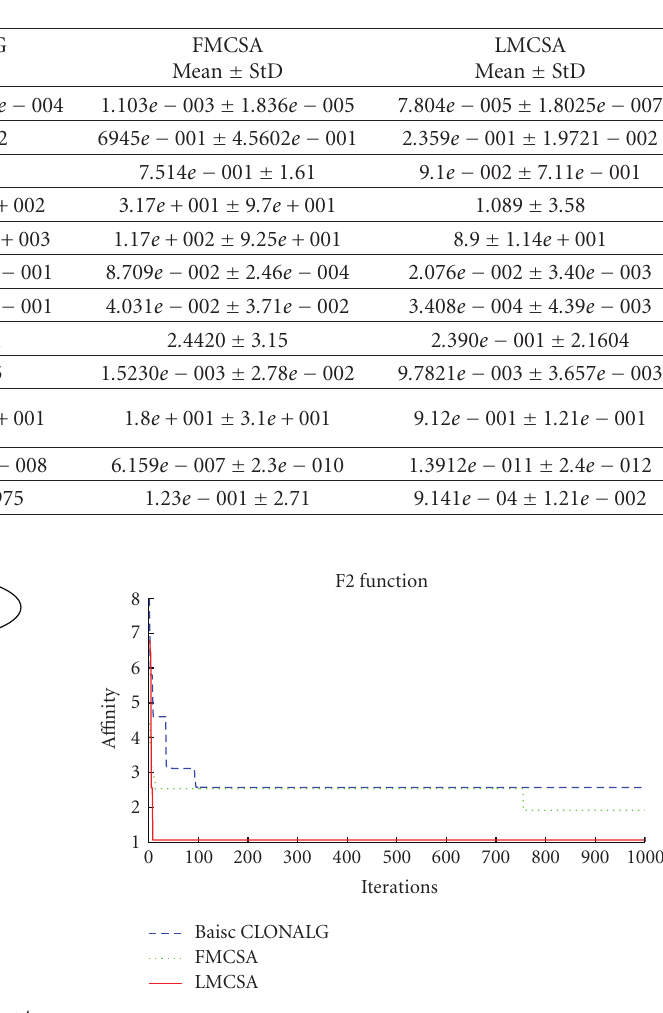
Figure 4: Convergent performances on Schwefel’s Problem 2.22 function ( f 2).